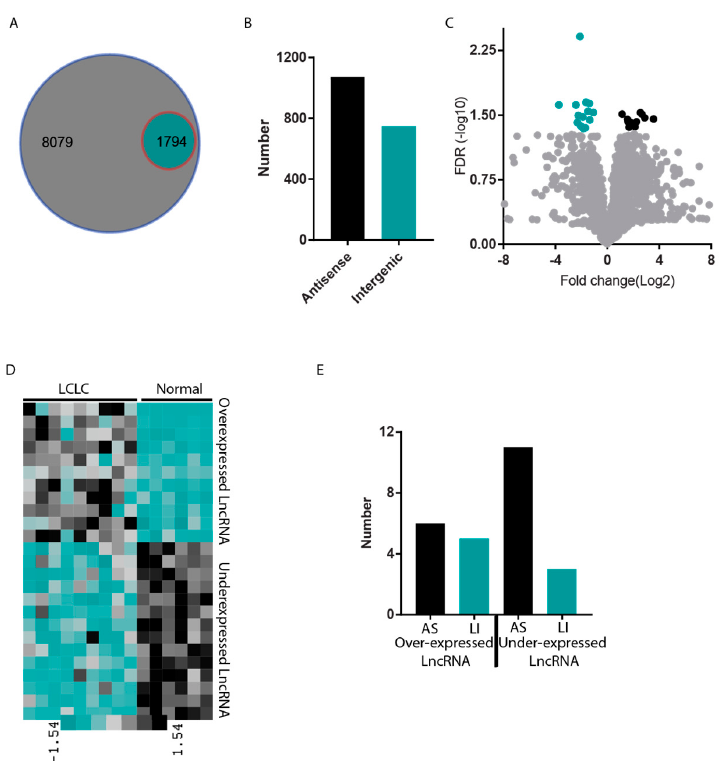
Figure 1. Expression profile of long non ‐ coding RNAs in large cell lung carcinoma (LCLC). ( A ) Venn diagram presenting total number of annotated LncRNA and expressed RNA. Big circle represents total number of LncRNA annotated and smaller circle represents the expressed LncRNA in LCLC. ( B ) Bar diagram showing number of intergenic and antisense LncRNA in expressed LncRNAs. ( C ) A volcano plot to show the significantly differentially expressed LncRNA in LCLC. Black dots show overexpressed genes and blue dots show underexpressed LncRNAs. ( D ) Heat map repressing the expression pattern of significantly differently regulated gene in LCLC. Color bar indicates the expression level with black high expression and Blue low expression. ( E ) Bar diagram to show the number of Antisense (AS) and Long intergenic differential expressed in LCLC.